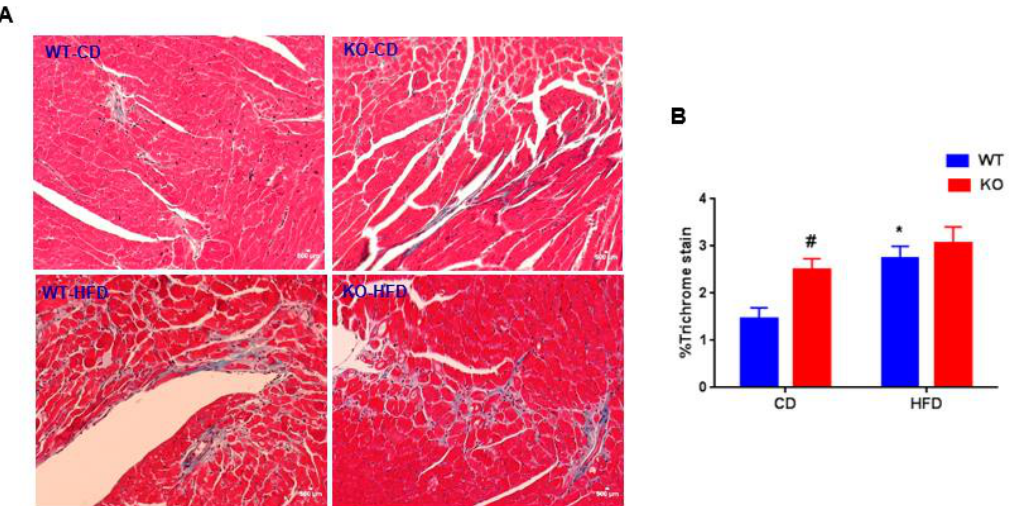
Figure 4. HFD increases fibrosis in WT and KO hearts: ( a ) Representative images of the left ventricle (LV) in WT and KO hearts stained with Masson trichrome 55 weeks post CD or HFD, ( b ) percent fibrosis was determined from 6–8 random images taken from six animals from each group. * p < 0.05 CD vs. HFD; # p < 0.05 WT vs. KO.